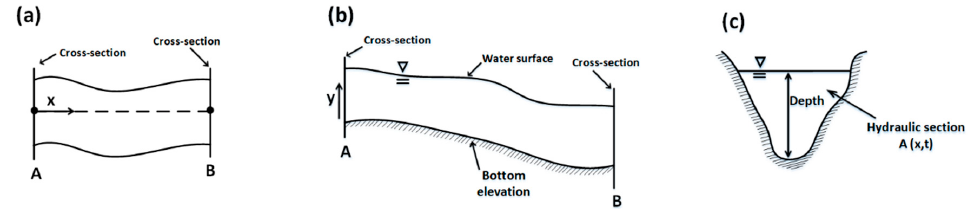
Figure 1. Schematic diagram of river illustrates in ( a ) top view, ( b ) longitudinal view, and ( c ) the hydraulic section.